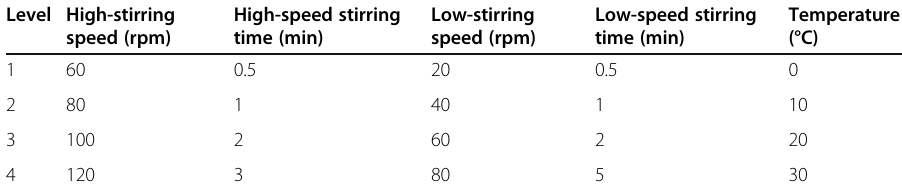
Table 2 Different hydraulic conditions Level High-stirring speed (rpm)